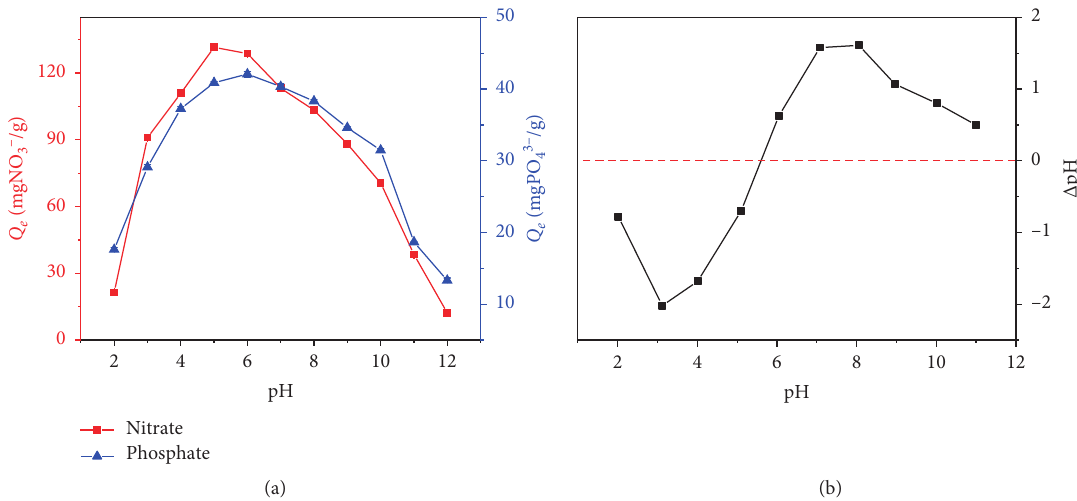
Figure 8: (a) Effects of initial solution pH on nitrate and phosphate adsorption. (b) The isoelectric point of ferric oxide-amine